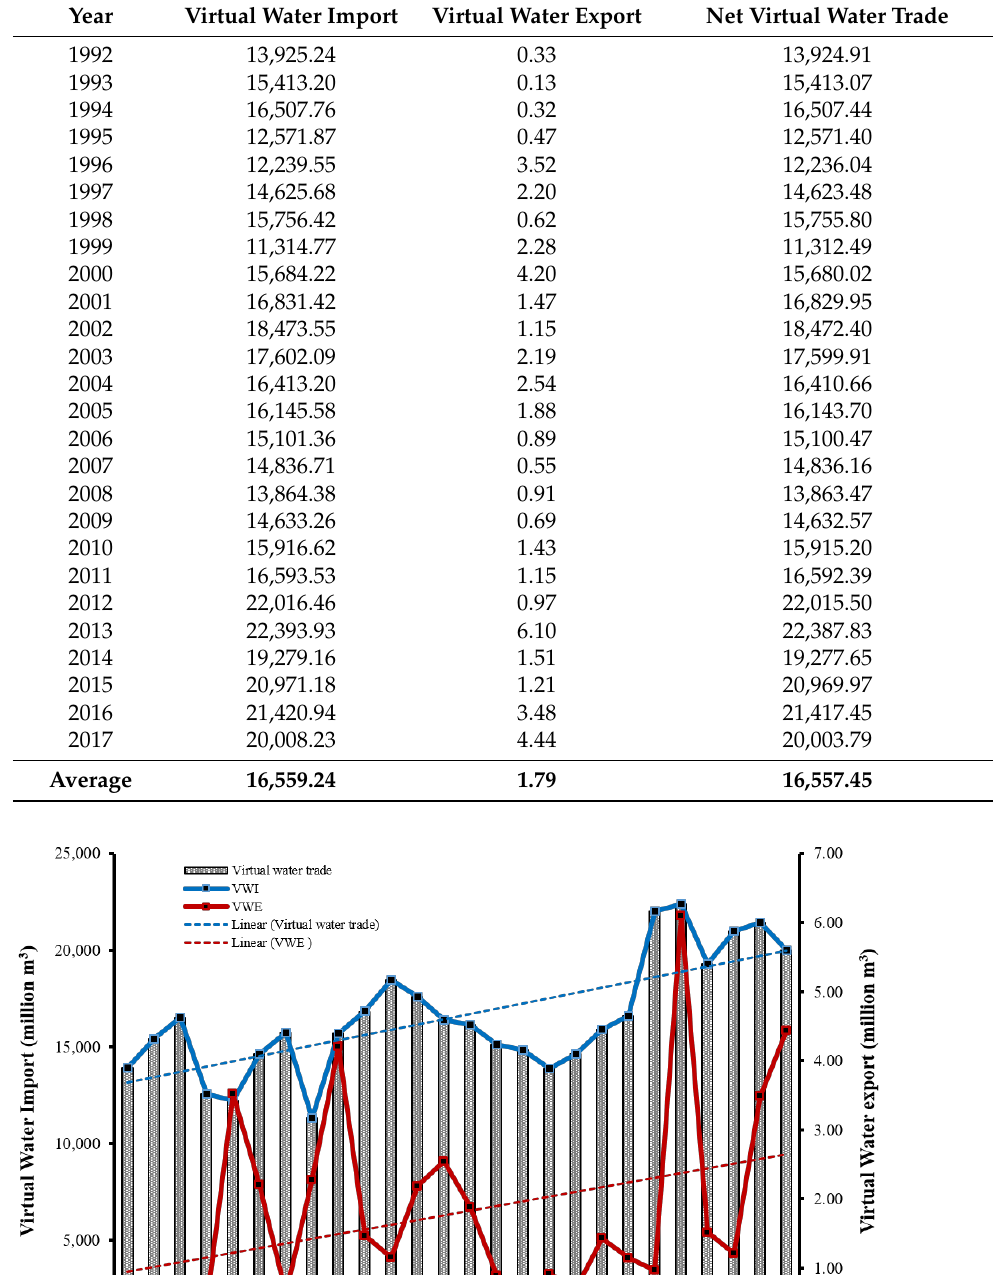
Table 4. South Korea’s net virtual water trade for grain crops (million m 3 ).